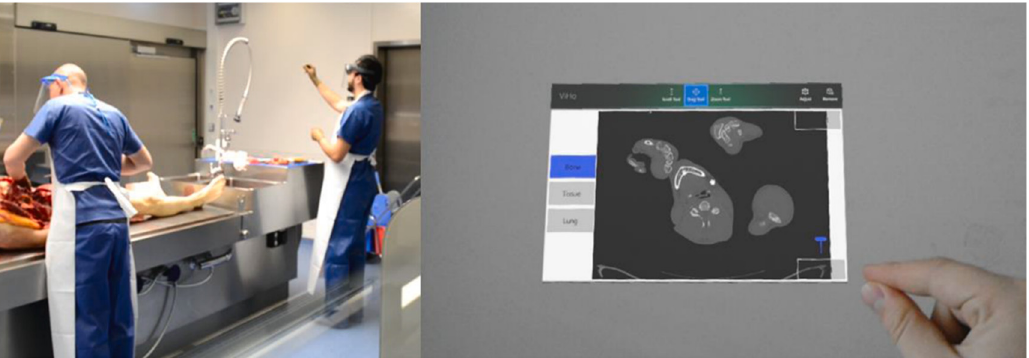
Figure 6. Scene of performing virtual autopsy using AR device. ( Left ) Display of the setup used in this study. ( Right ) Simulated view seen by the participant [49].